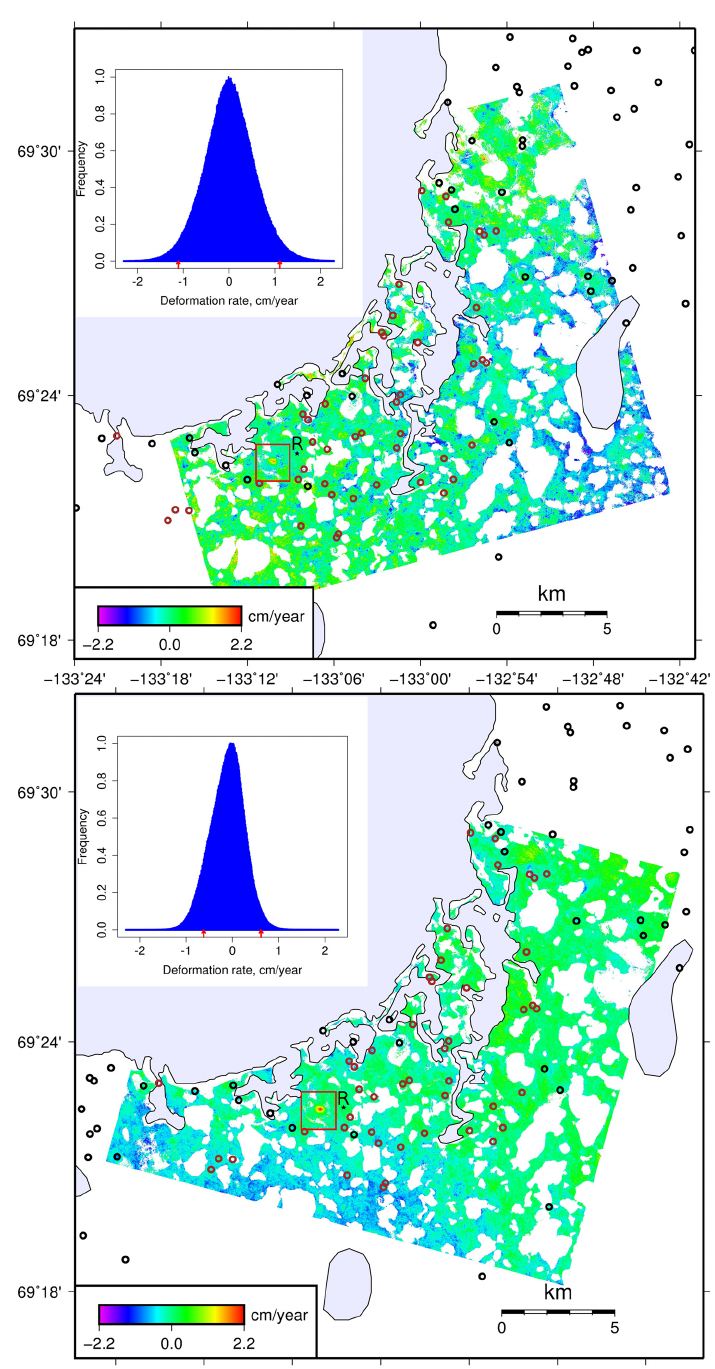
Figure 6. Line-of-sight linear deformation rate during 2011–2014 period computed from ascending (top) and descending (bottom) RADARSAT-2 U3 imagery. Study site is outlined in red. Black circles show locations of known pingos from Canada Base Map (GeoGratis Web Services, Natural Resources Canada). Brown circles show locations of suspected pingos visually identified in high-resolution optical imagery. Decorrelated areas are shown in white. R is reference region. Extents in top-left corner show deformation rate histograms with red arrows marking 95% confidence